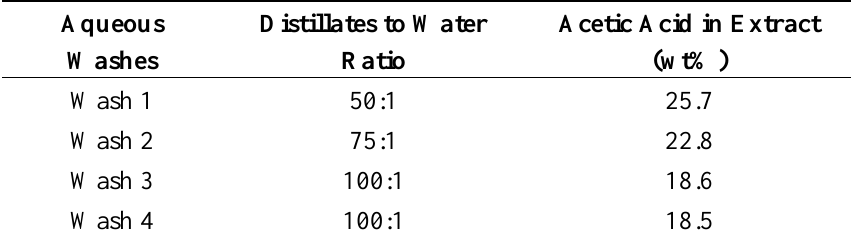
Table 1. Acetic acid concentration in aqueous extracts from the organic liquid product (OLP) generated by the non-catalytic cracking of soybean